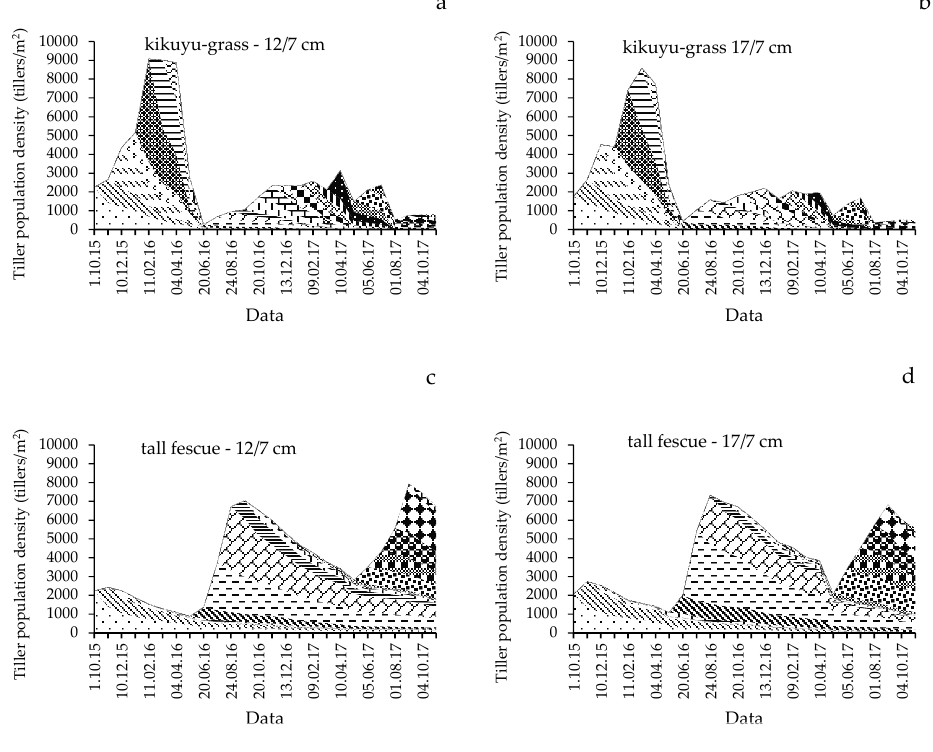
kikuyu-grass + tall fescue (17/7 cm) Figure 4.